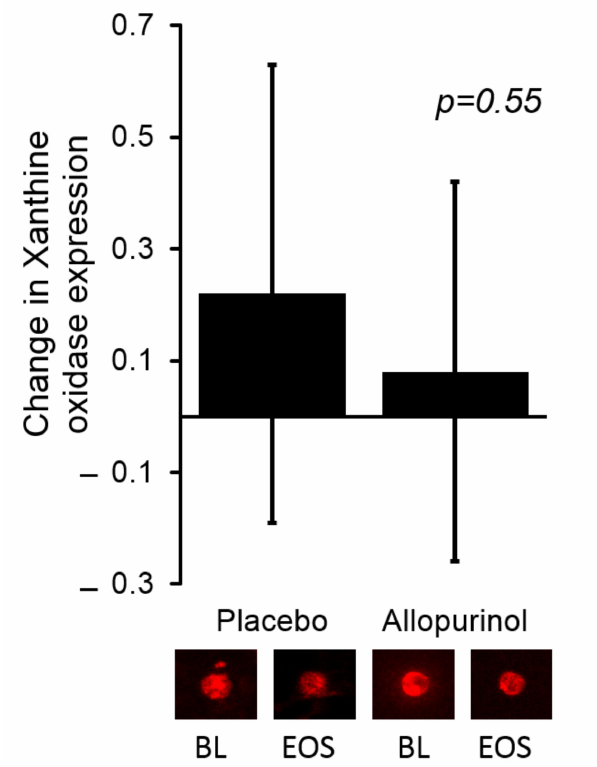
Figure 1. There was no significant change in the expression of endothelial XO when comparing allopurinol to placebo. The bars in the graph represent the change from baseline for each study group. Representative images of the endothelial expression of XO are shown below the bar graph for the baseline (BL) and end of study (EOS) visits for the corresponding study group. Values for each sample were reported as arbitrary units and represent ratios of endothelial cell protein expression to human umbilical vein endothelial cell (HUVEC)